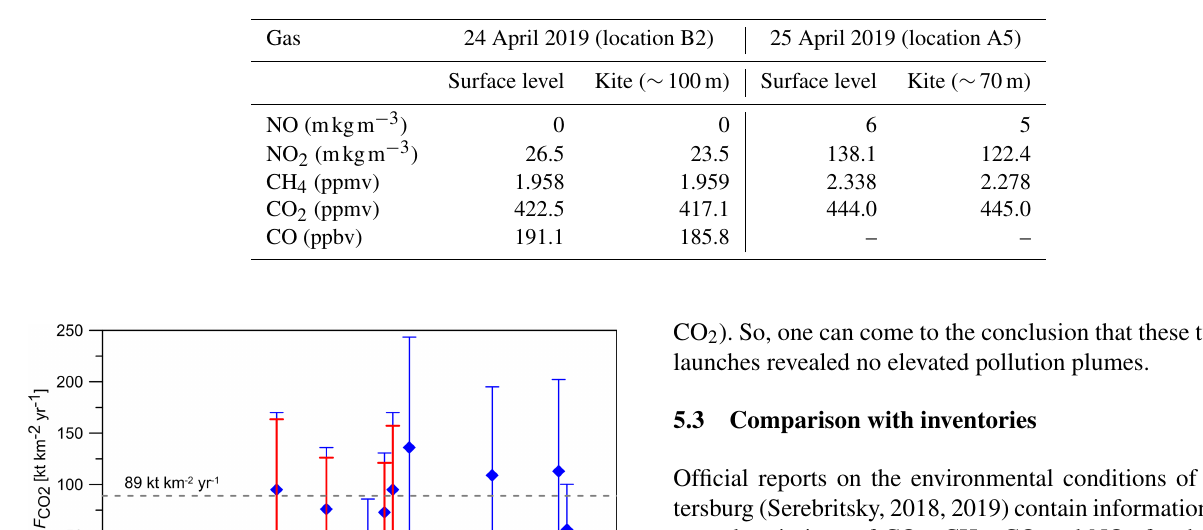
Table 3. Comparison of the gas concentrations in air samples collected at the surface and elevated levels on 24 April 2019 and 25 April 2019 at the locations of FTS measurements inside the city plume.